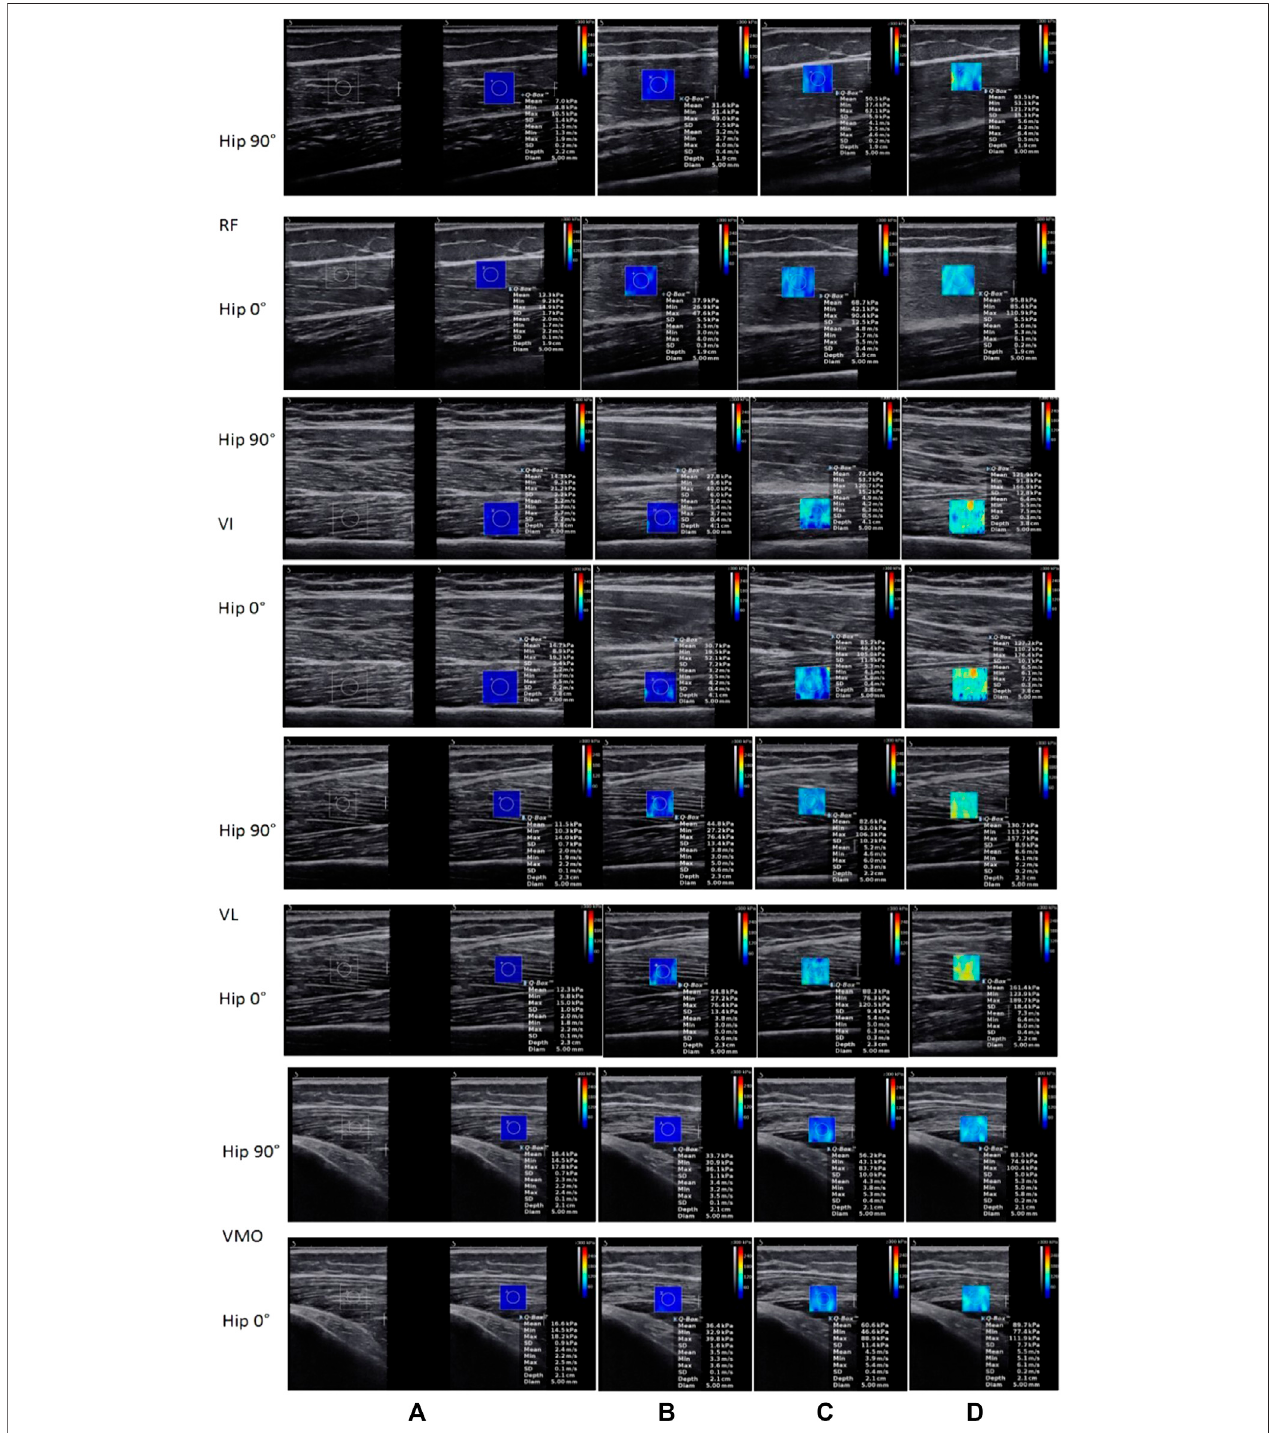
FIGURE3| Theshearmodulusofmuscleswereshownasresting(0%)and10,20,and30%MVICfrom (A – D) withblue meanssofterandred meansstiffer.Using SWE, we can see real-time changes in muscle stiffness through real-time color changes.